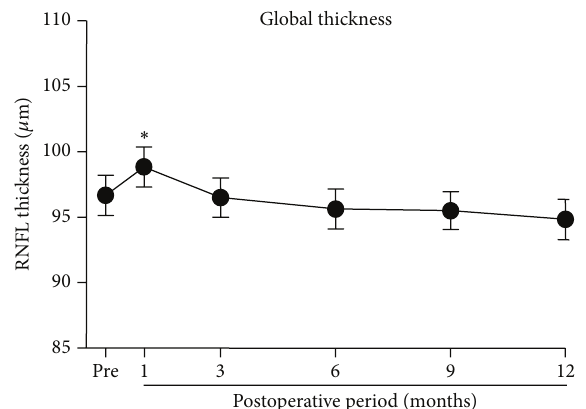
Figure 4: The means of the absolute global RNFL thickness are plottedagainstthepostoperativetime.Means ± SEMs.RNFL:retinal nerve fiber layer, ∗ 𝑃 < 0.01